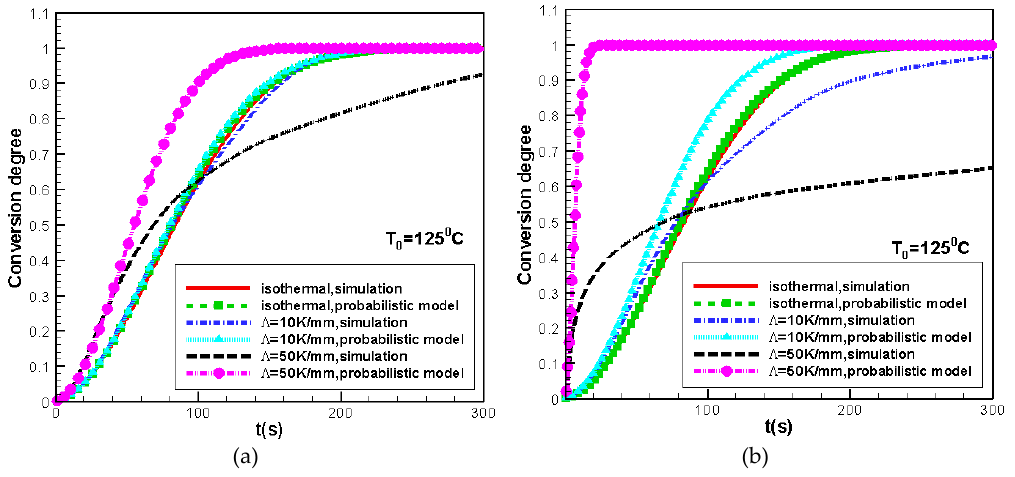
Figure 9. Conversion degree of the melt into spherulites at isothermals of T 0 = 125 ◦ C: ( a )